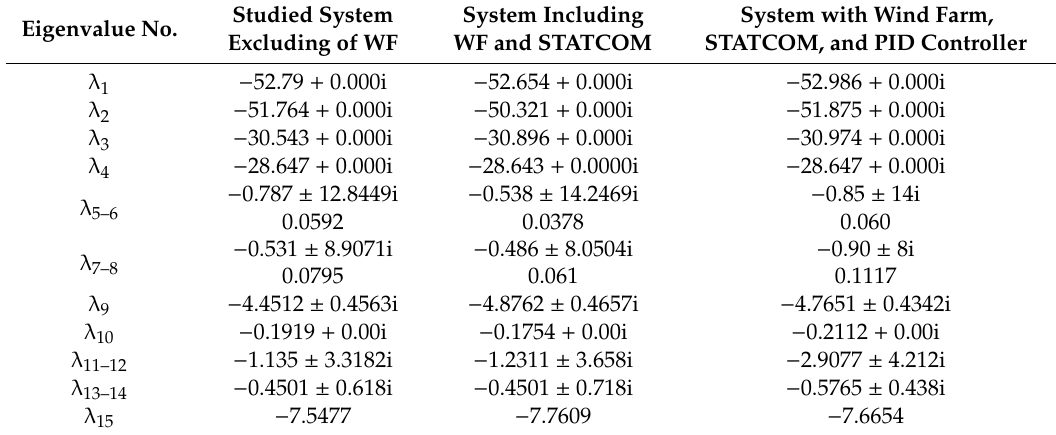
Table 1. Eigenvalues of the test system [damping ratio] at 12 m / s wind speed. Eigenvalue